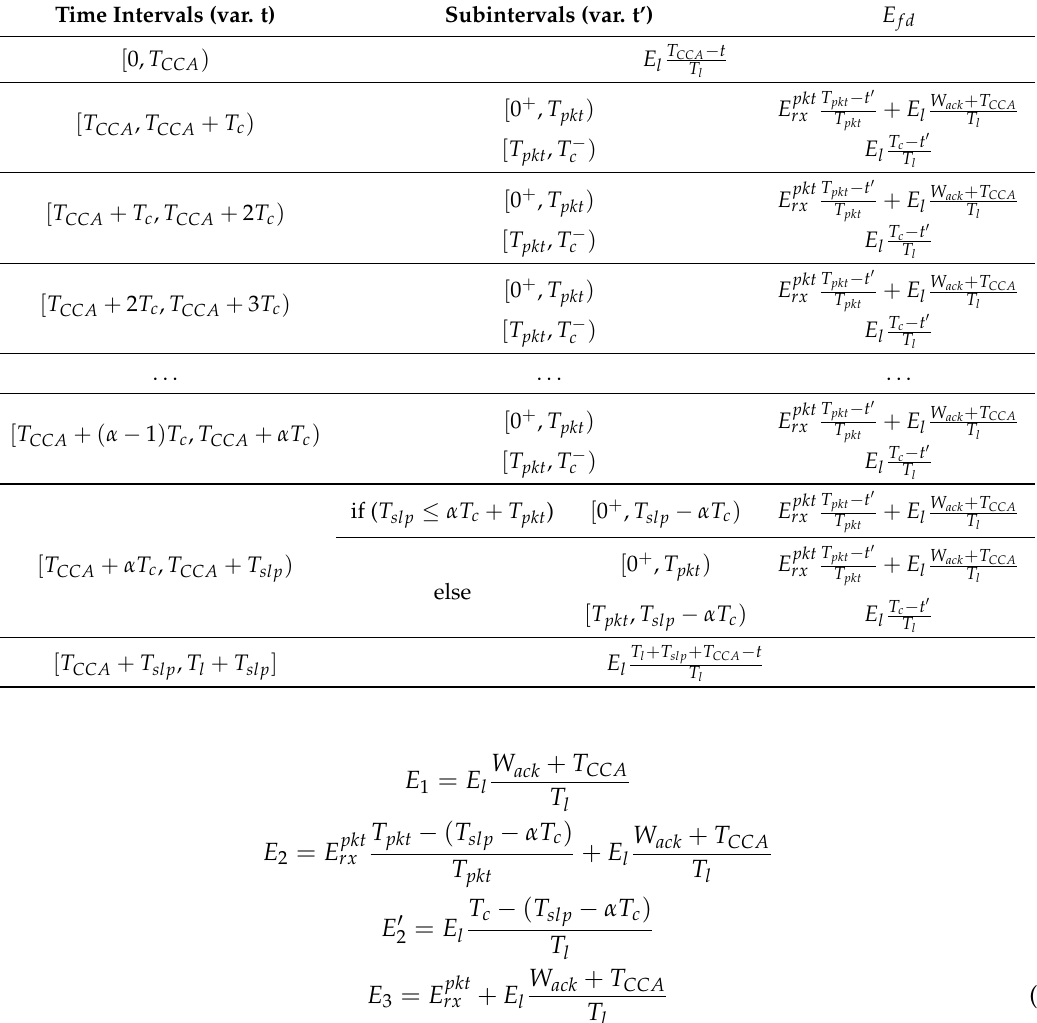
Table 2. Characterization of ( E fd ) in terms of the transmitter-receiver asynchrony. Time Intervals (var.